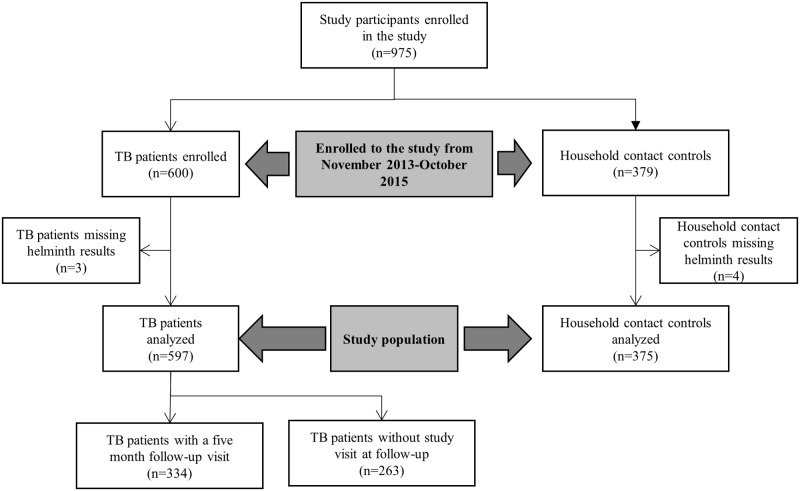
Study participants’ flow diagram.